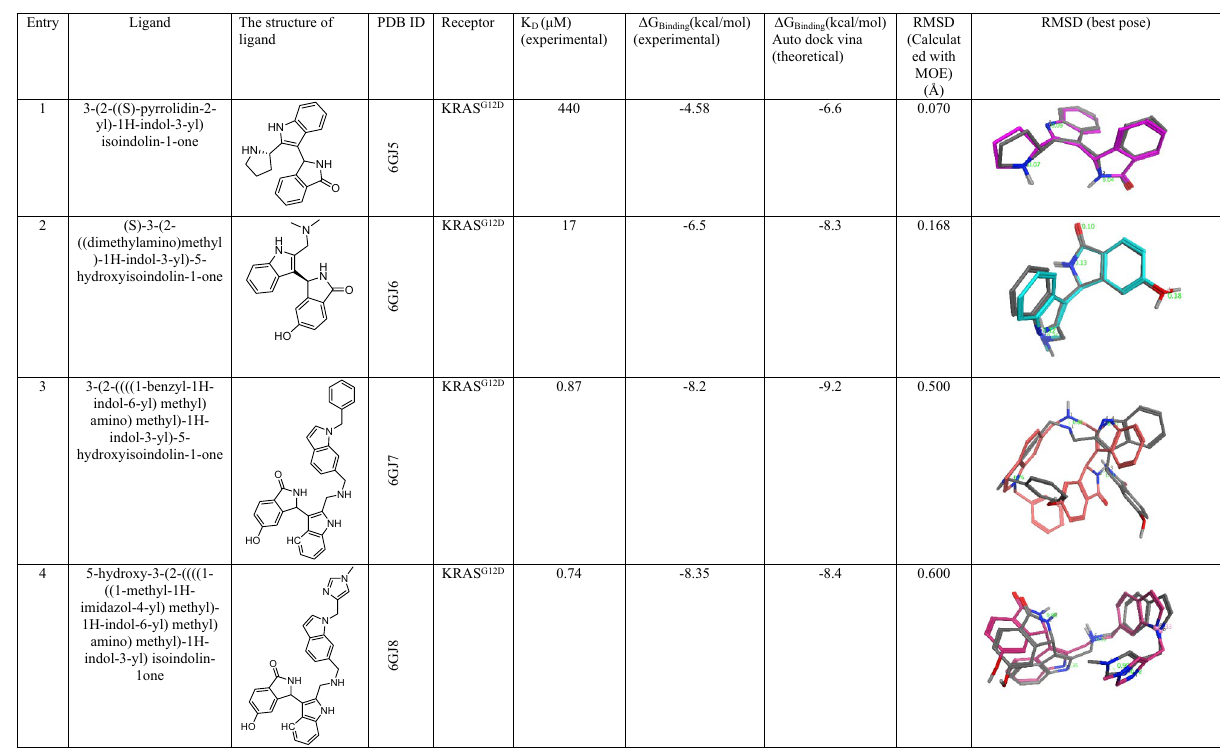
Table 4. The calculated and experimental ΔG Binding (kcal/mol) values of some known compounds toward KRAS